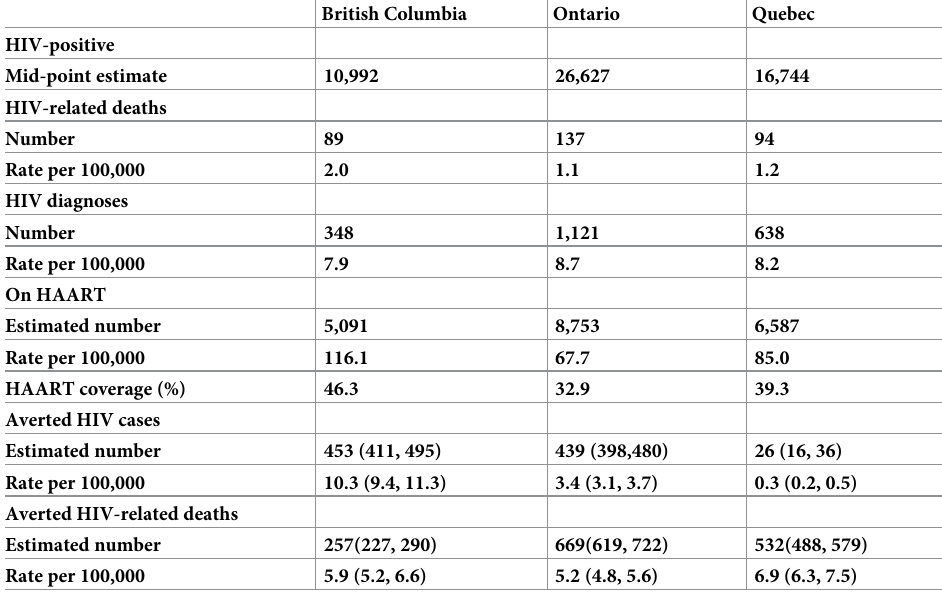
Table 2. Characteristics of those infected with HIV in British Columbia, Ontario and Quebec, 2008. British